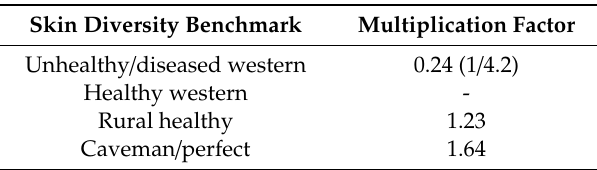
Figure 9. Graph showing how to obtain a multiplication factor between “healthy” and “unhealthy” western skin diversity, to be used in transferring the remaining benchmarks from our 2017 work to the new skin health measuring mechanism. Table 1. Table showing the multiplication factors needed to get from the benchmark for “healthy western skin” to the other benchmarks listed in our 2017 work.